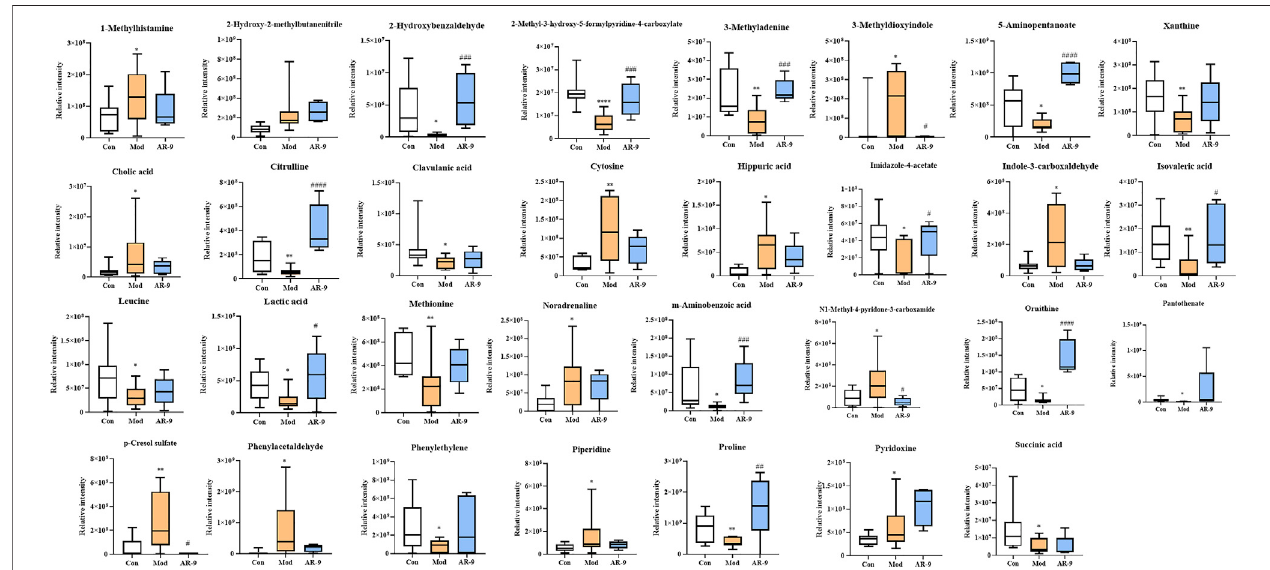
FIGURE 4 | Results of 31 differential metabolites among three groups. * p < 0.05, ** p < 0.01, *** p < 0.001, and **** p < 0.0001 and # p < 0.05, ## p < 0.01, ### p < 0.001, and #### p < 0.0001 vs. Con or Mod group. AR-9 Treatment restored the dysbiosis of the gut microbiota in HL rats induced by HFD.